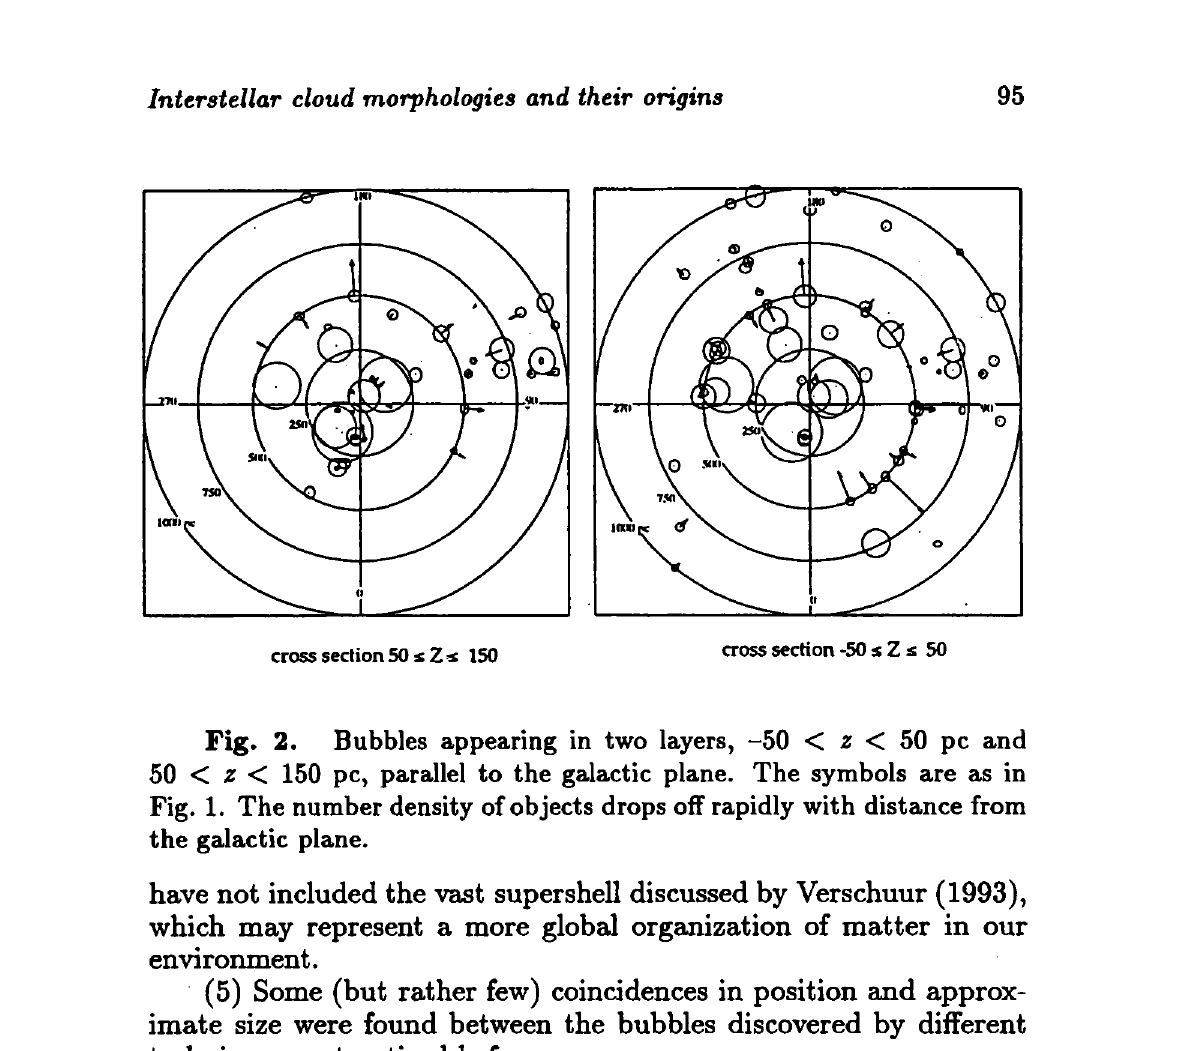
Fig. 2. Bubbles appearing in two layers, -50 < ζ < 50 pc and 50 < ζ < 150 pc, parallel to the galactic plane. The symbols are as in Fig. 1. The number density of objects drops off rapidly with distance from the galactic